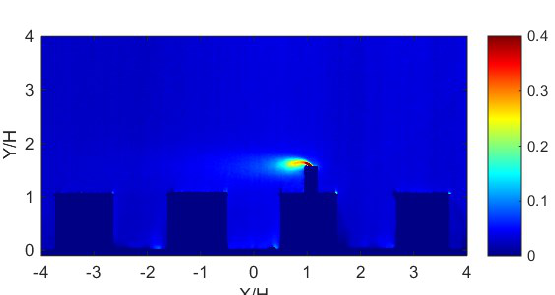
Fig. 13. Mean non- dimensional concentration C/C 0 field (C 0 is the mean concentration measured at the top of the chimneystack) for pitched roof and a chimneystack (on the upstream pitch) with h/H = 0.50; the flow moves from the right to the left.